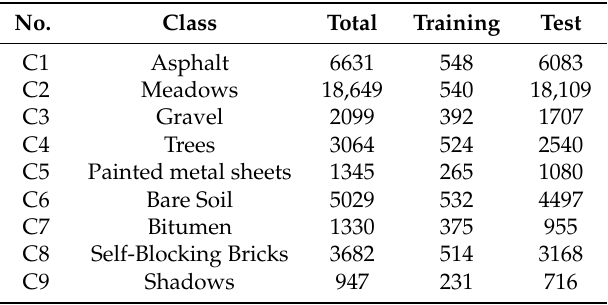
Table 2. Number of pixels for training/testing and the total number of pixels for each class in the Pavia University ground truth